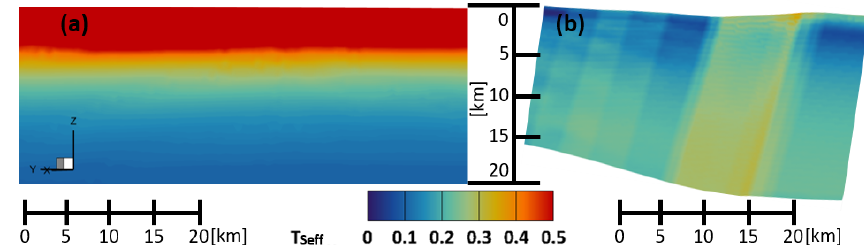
Figure 4. Vertical section of T Seff along faults. (a) T Seff of a northern part of the Albstadt Shear Zone decreases over the entire depth; (b) T Seff of an eastern part of the Midi-Aachen Thrust slightly increases again (after an initial strong decrease) as indicated by the shift from blue to greenish colors at greater depths. Color bar applies to both (a) and (b)